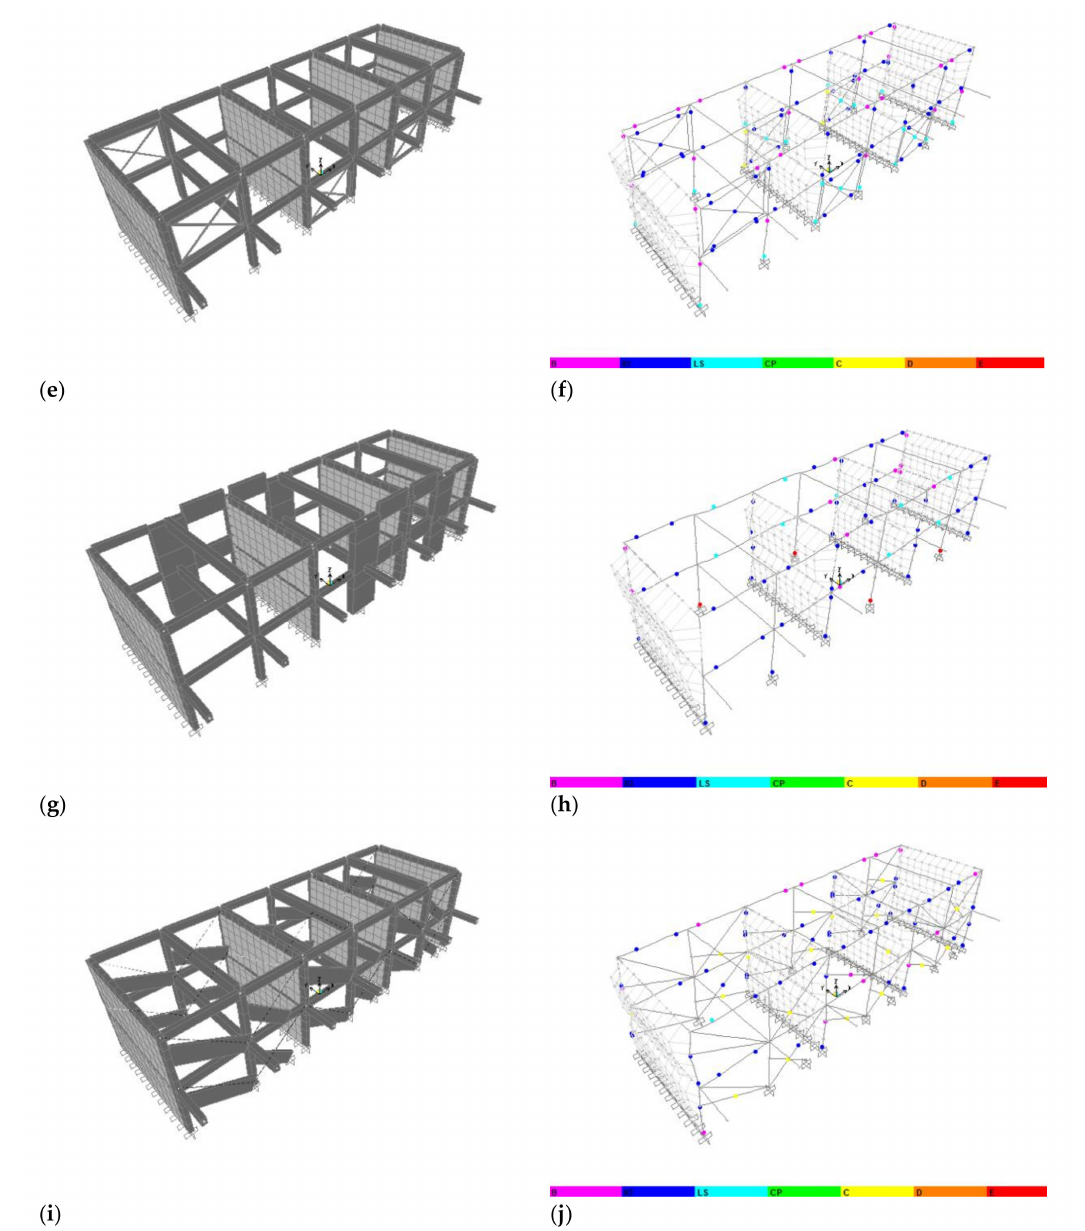
Figure 8. 3D Finite Element model and collapse mechanisms in the longitudinal direction (weak direction) for the original building type ( a , b ) and for the retrofitting intervention A 1 ( c , d ), A 2 ( e , f ), A 3 ( g , h ), and A 4 ( i , j